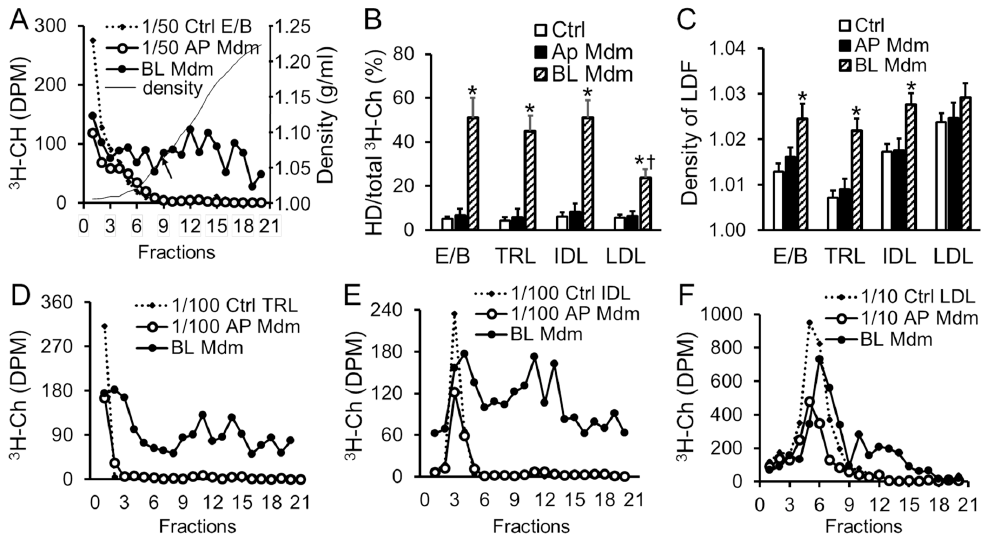
Figure 3. Transendothelial transport of apoB-LPs resulted in cholesterol redistribution among lipoprotein fractions. The AP side of the MAEC monolayer was incubated with 20 µg/mL of 3 H-Ch-labeld E/B-LPs (E/B) ( A ), TRLs ( D ), IDLs ( E ), or LDLs ( F ); the BL side was incubated with medium alone for 24 h. The AP and BL media (Mdm), and 20 µg of cell-untreated control 3 H-Ch-labeled lipoproteins (i.e., Ctrl E/B, TRL, IDL, or LDL), were subjected to DG ultracentrifugation. Twenty fractions were collected for determination of density and radioactivity. The level of 3 H-Ch was expressed by radioactivity counts: 1/100, 1/50, 1/10 (radioactivity counts in Ctrl lipoproteins and AP medium were divided by 100, 50, or 10). A representative density curve was presented in panel A . The arrow pointing to the density curve indicated d = 1.063 g/mL. ( B ): The level of 3 H-Ch in the HD fractions of the AP and BL media and control lipoproteins (Ctrl) was expressed as the % of the HD 3 H-Ch in the total 3 H-Ch (HD/total 3 H-Ch), which was calculated as follows: (The radioactivity in fractions 10–20/the radioactivity in fractions 1–20) × 100. ( C ): The average density of the lipoproteins in low density fractions (LDF), i.e., fractions 1–9, was calculated as follows: ( ∑ 𝐷𝑖𝑅𝑖/∑ 𝑅𝑖 ), where D and R are the hydrated density and radioactivity count of each fraction, respectively. Values represent the mean ± SE of four experiments; * p < 0.05 vs. the Ctrl EB-LPs, TRLs, IDLs, or LDLs; † p < 0.05 vs. BL medium containing 3 H-Ch EB-LPs, TRLs, or IDLs.